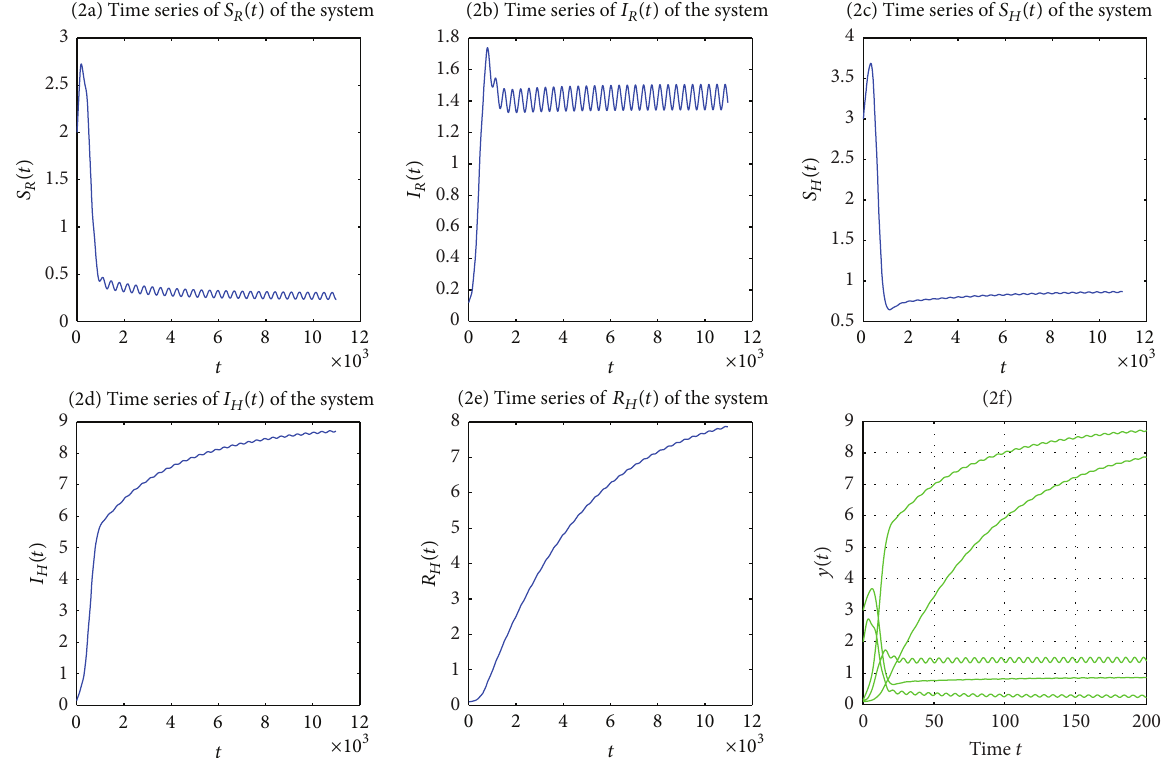
Figure 2: (a)–(e) show that system (3) with initial conditions (𝑆 𝑅 (0),𝐼 𝑅 (0),𝑆 𝐻 (0),𝐼 𝐻 (0),𝑅 𝐻 (0)) = (2,0.12, 3, 0.15, 0.1) is permanent.